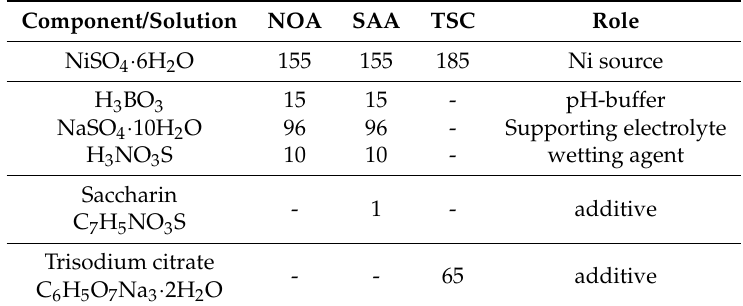
Table 1. Composition of the electrolytes used for deposition. All components are measured in units (g/L). NOA = no organic additive; SAA = saccharin additive; TSC = trisodium